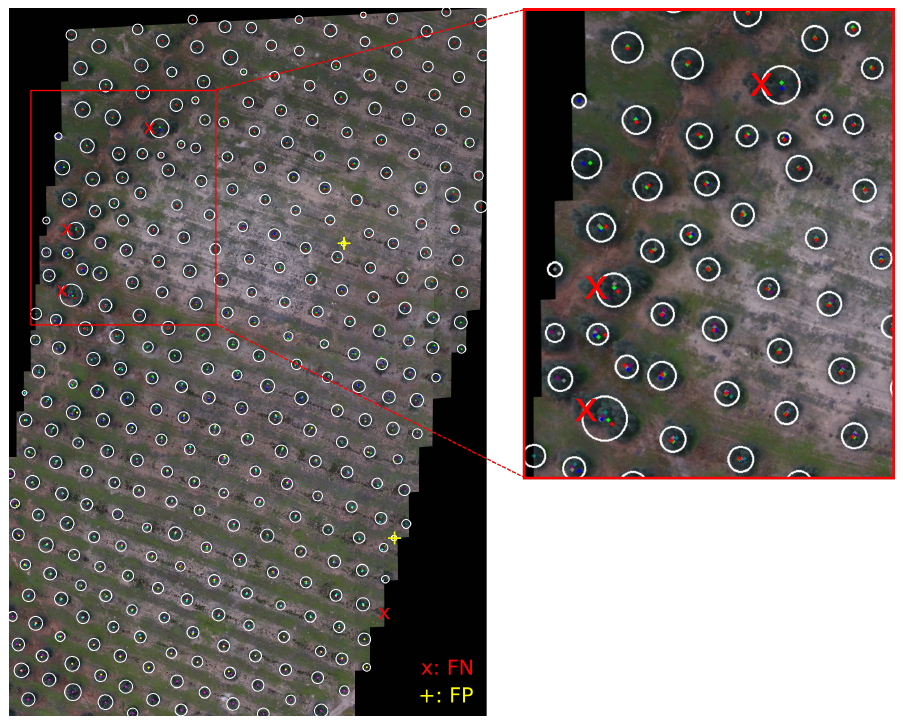
Figure 11. Tree detection in a sequence of 10 images.